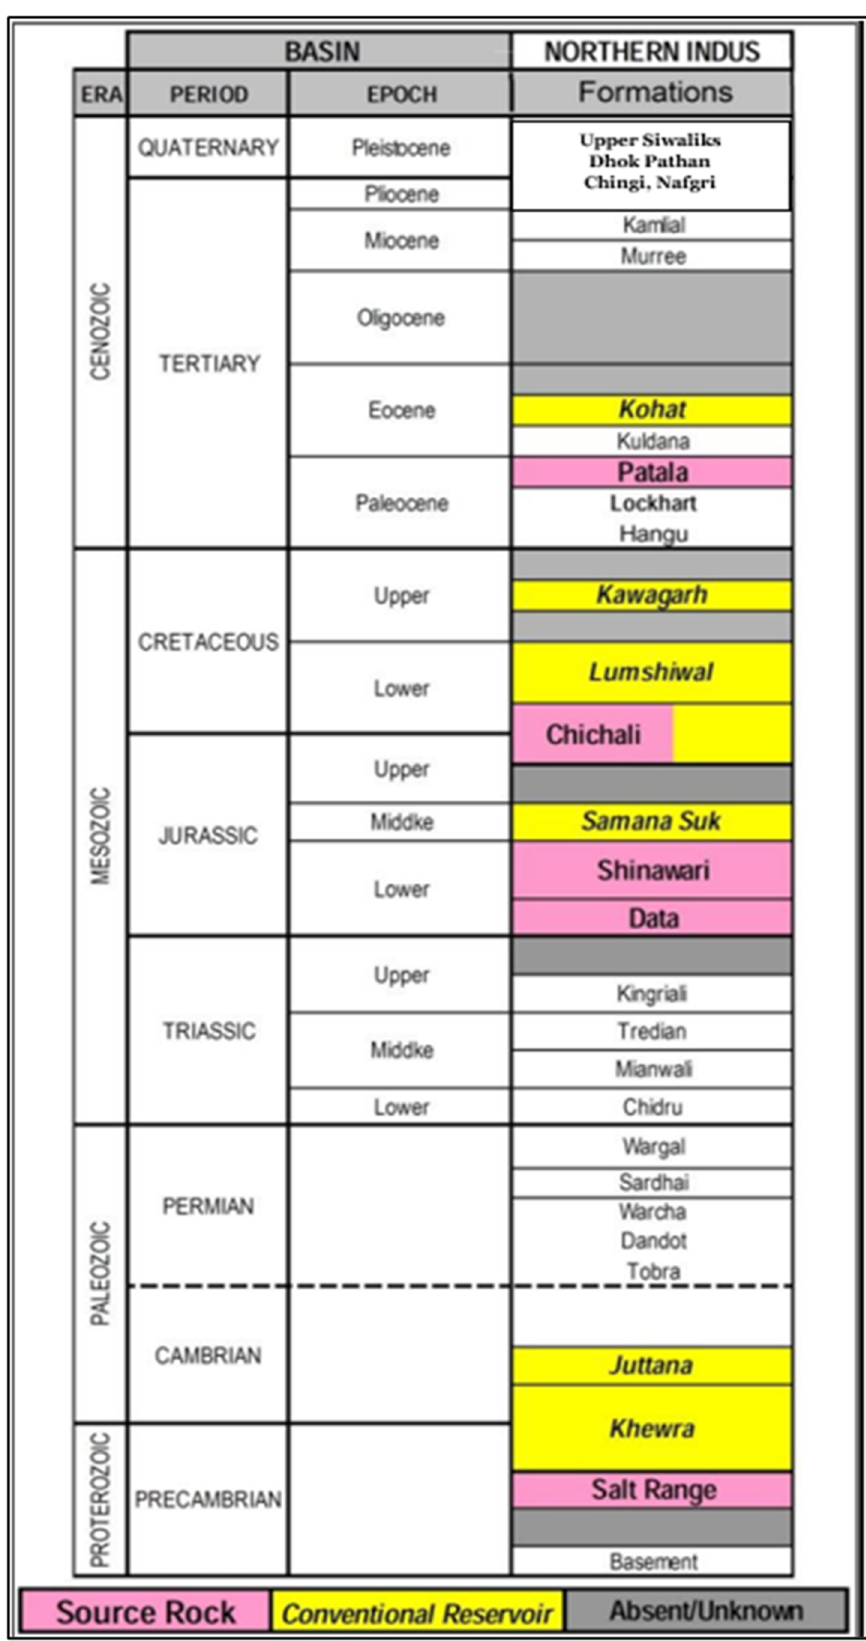
Figure 2. Stratigraphic succession of Kohat Basin indicates the source and reservoir formations, modified from [21].